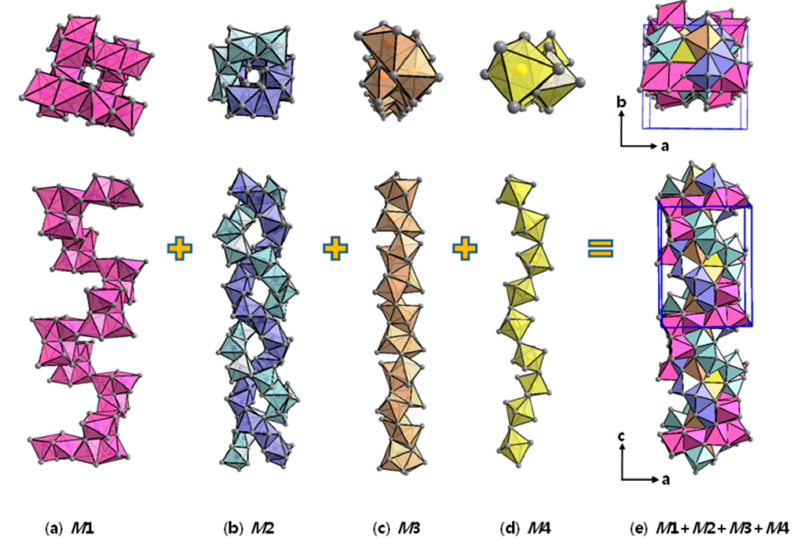
Figure 3. Schematic illustration showing the formation of the Yb 14- x Ca x AlSb (4.81(3) ≤ x ≤ 10.57(2)) series (Ca 14 AlSb 11 -type) described as a combination of four different types of spiral-shaped 1D octahedra chains. ( a ) M 1; ( b ) M 2; ( c ) M 3; ( d ) M 4; ( e ) M 1 + M 2 + M 3 + M 4. The substituting Ca 2+ cations are found all over the four Yb 2+ sites with different partial occupations varying from ca. 31%–78%, as listed in Table S1. In addition, the bond distances between Al and Sb1 in the (AlSb 4 ) 9 − tetrahedron and between Sb3 and Sb4 in the (Sb 3 ) 7 − are linear trimer ranged, respectively, from 2.712–2.714 Å and from 3.190–3.193 Å (Table S2), which are comparable to 2.718 Å